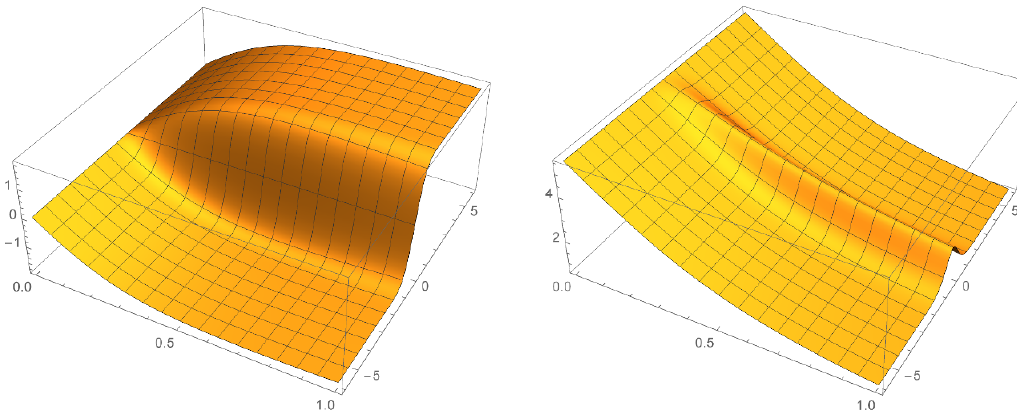
Figure 1 . The bulk con(cid:12)gurations of the (cid:12)elds (cid:30) ( z; x ) (left panel) and A t ( z; x ) (right panel) for (cid:22) = 5 : 5.